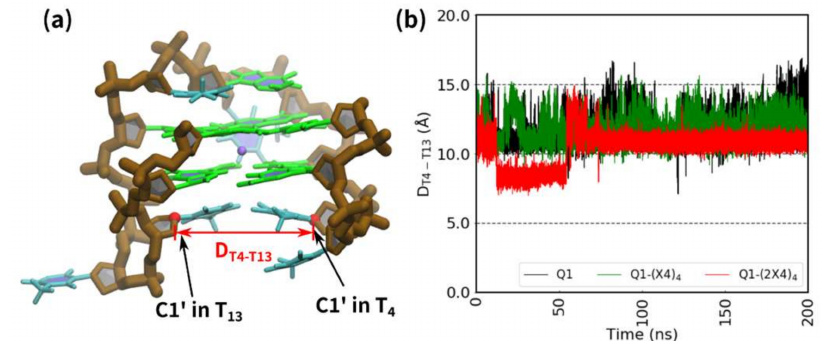
Figure 4. Fluctuation of loop regions in the G-quadruplexes. ( a ) Positions of the C1 (cid:48) atoms of Q1 are annotated, and the distance between these atoms is indicated by a red arrow. Brown, green, and cyan sticks show the backbone, guanine bases, and thymine bases, respectively. The purple sphere represents a potassium cation. ( b ) Change in distance between the C1 (cid:48) atoms (T 4 –T 13 ) in Q1 (black), Q1-(X4) 4 (green), and Q1-(2X4) 4 (red). We also estimated the total electrostatic (ES), exchange repulsion (EX), charge transfer (CT), and dispersion force (DI) energies to confirm quantitatively the interactions found in the structural analysis. Graphs showing interaction energies are shown in Figure 5. Interactions between T 4 and other bases are highlighted by dashed lines. Blue squares with black arrows in ES and DI indicate hydrogen bonds and stacking interactions in G-quartets, respectively. In the ES graphs for Q1-(X4) 4 , there are dark blue squares in the dashed line (Figure 5b, ES graphs, green arrows). These blue squares show the hydrogen bond between T 12 and thymine base in (X4) 4 in the vicinity. In contrast, the dark blue squares in the DI graphs represent CH- π interactions (Figure 5b,c, DI graphs, red arrows). The results indicated that linear and dibranched TEGs stabilized G-quadruplex hydrogen bond and CH- π interactions.